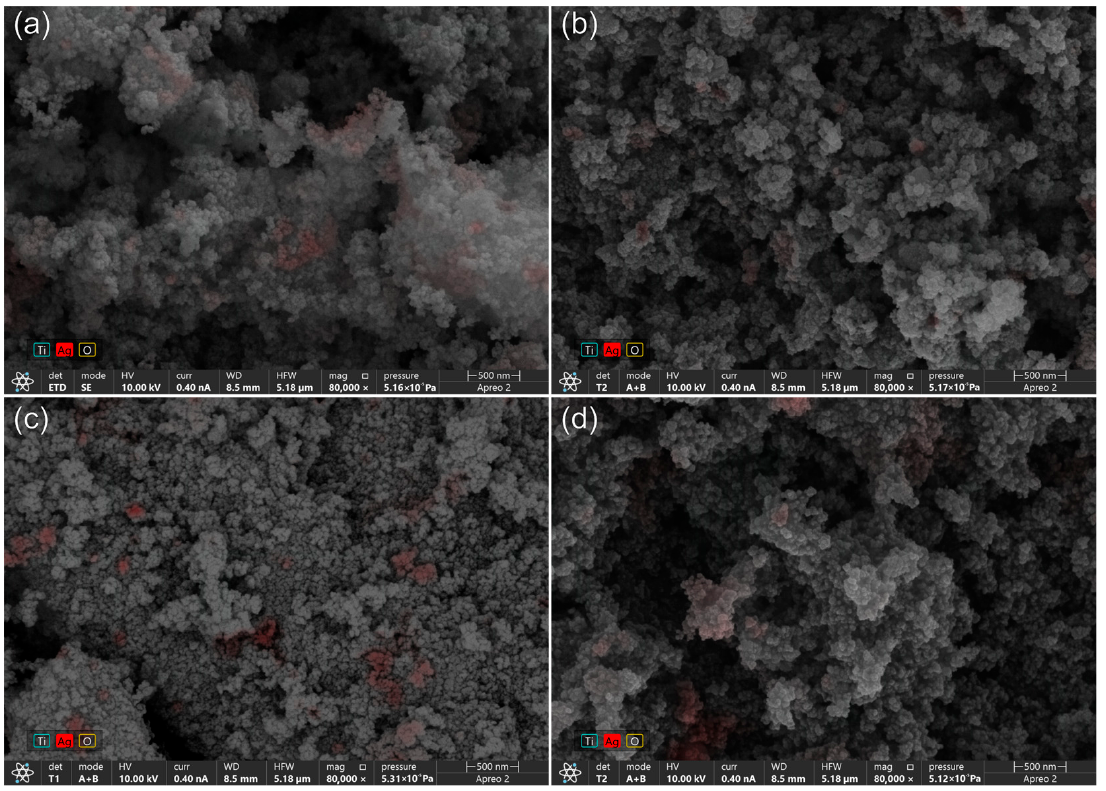
Figure 5. SEM images with EDX mapping of deposited Ag on @TiO 2 /Ag_IMP ( a ), @TiO 2 /Ag_H 2 O ( b ), P25/Ag_IMP ( c ), and P25/Ag_H 2 O ( d ).